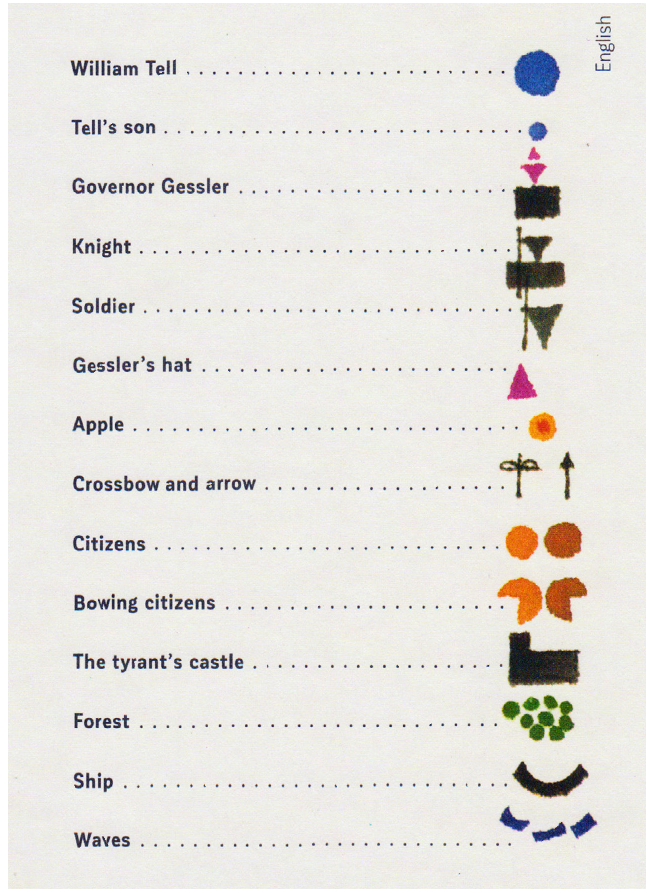
Fig. 7 Warja Lavater, Legend , Warja Lavater (1962), Wilhelm Tell , Basel: Basilius